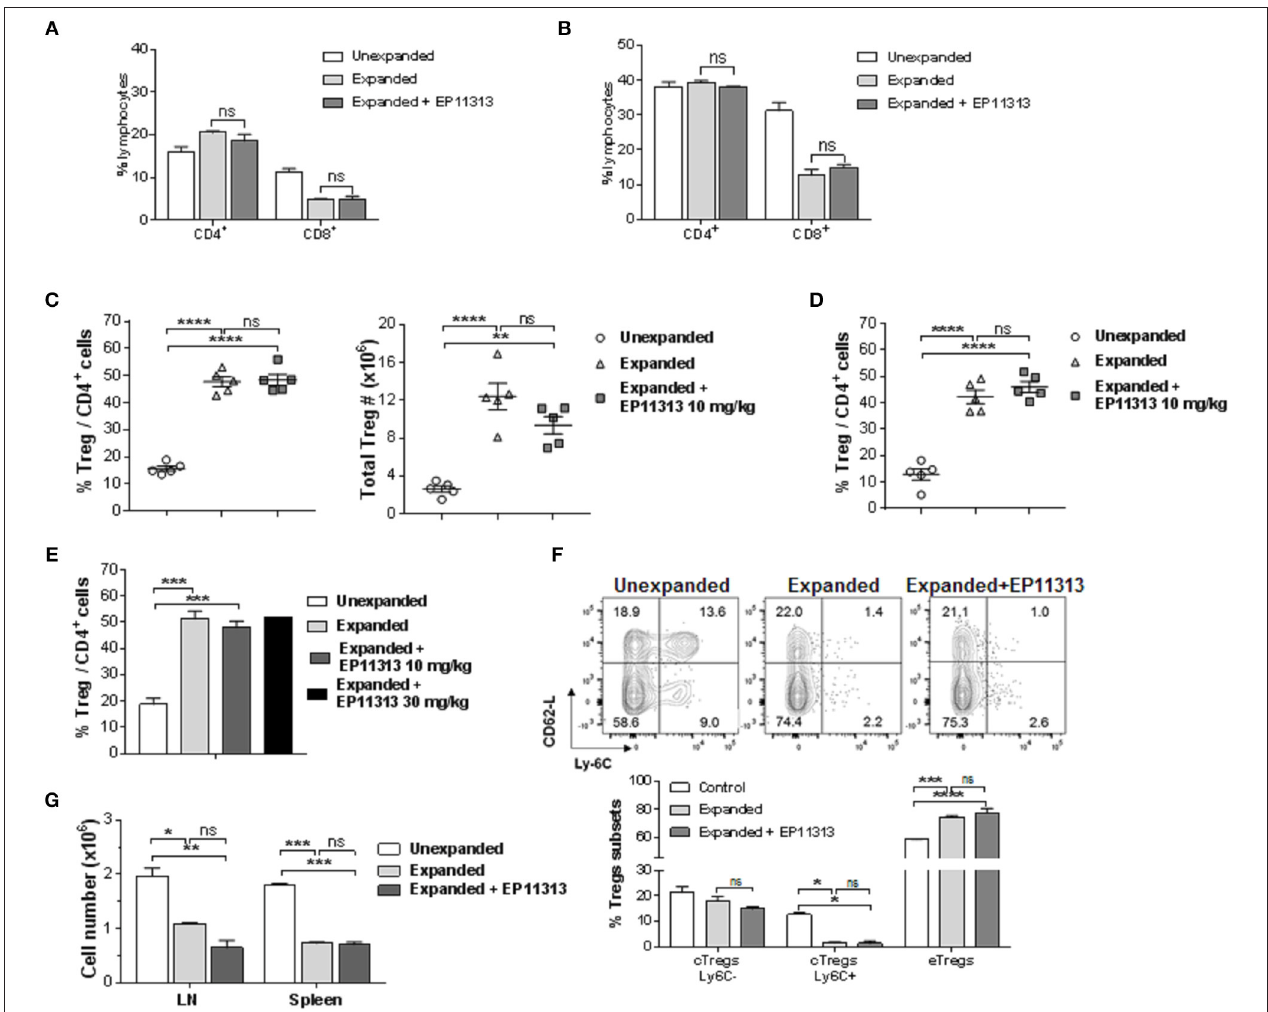
FIGURE 1 | In vivo treatment with BETi EP11313 does not interfere with Treg expansion, subset distribution and in vitro suppressor function. (A–G) Mice were injected i.p. with TL1A-Ig (on days 1–4) and rmIL-2 bound to the anti-IL-2 mAb (JES6-5H4, on days 4 and 6) and EP11313 (10 mg/kg per dose) or administered vehicle on days − 1 to 6 (twice per day). Mice were sacrificed on day 7. CD4 + or CD8 + frequency (%) in the spleen (A) and peripheral lymph nodes (pLN) (B) of mice undergoing Treg expansion (TL1A-Ig + low dose IL-2) in the presence or absence of BETi EP11313. Data representative of three independent experiments ( n = 2 mice/group). Splenic overall Treg frequency (%) within the CD4 fraction (CD4 + FoxP3 + /CD4 + ) cells (left) and total numbers splenic Tregs (right) are shown (C) . Treg (CD4 + FoxP3 + ) frequency (%) of total CD4 + cells in pLN (D) . Data are pooled from three independent experiments; n = 5 mice/group (C,D) . Treg frequency (%) of total CD4 + cells in expanded mice treated with EP11313 at 10 or 30 mg/kg (E) . Treg subset distribution determined by CD62-L and Ly-6C staining is shown as a representative contour plot (top) and a bar graph of data pooled from two independent experiments (bottom) (F) . No significant differences were observed in cTregs CD62L hi Ly-6C − or + and eTregs CD62L lo Ly-6C − in the Expanded + EP11313 treated mice vs. Expanded mice (F) . Treg expansion leads to a